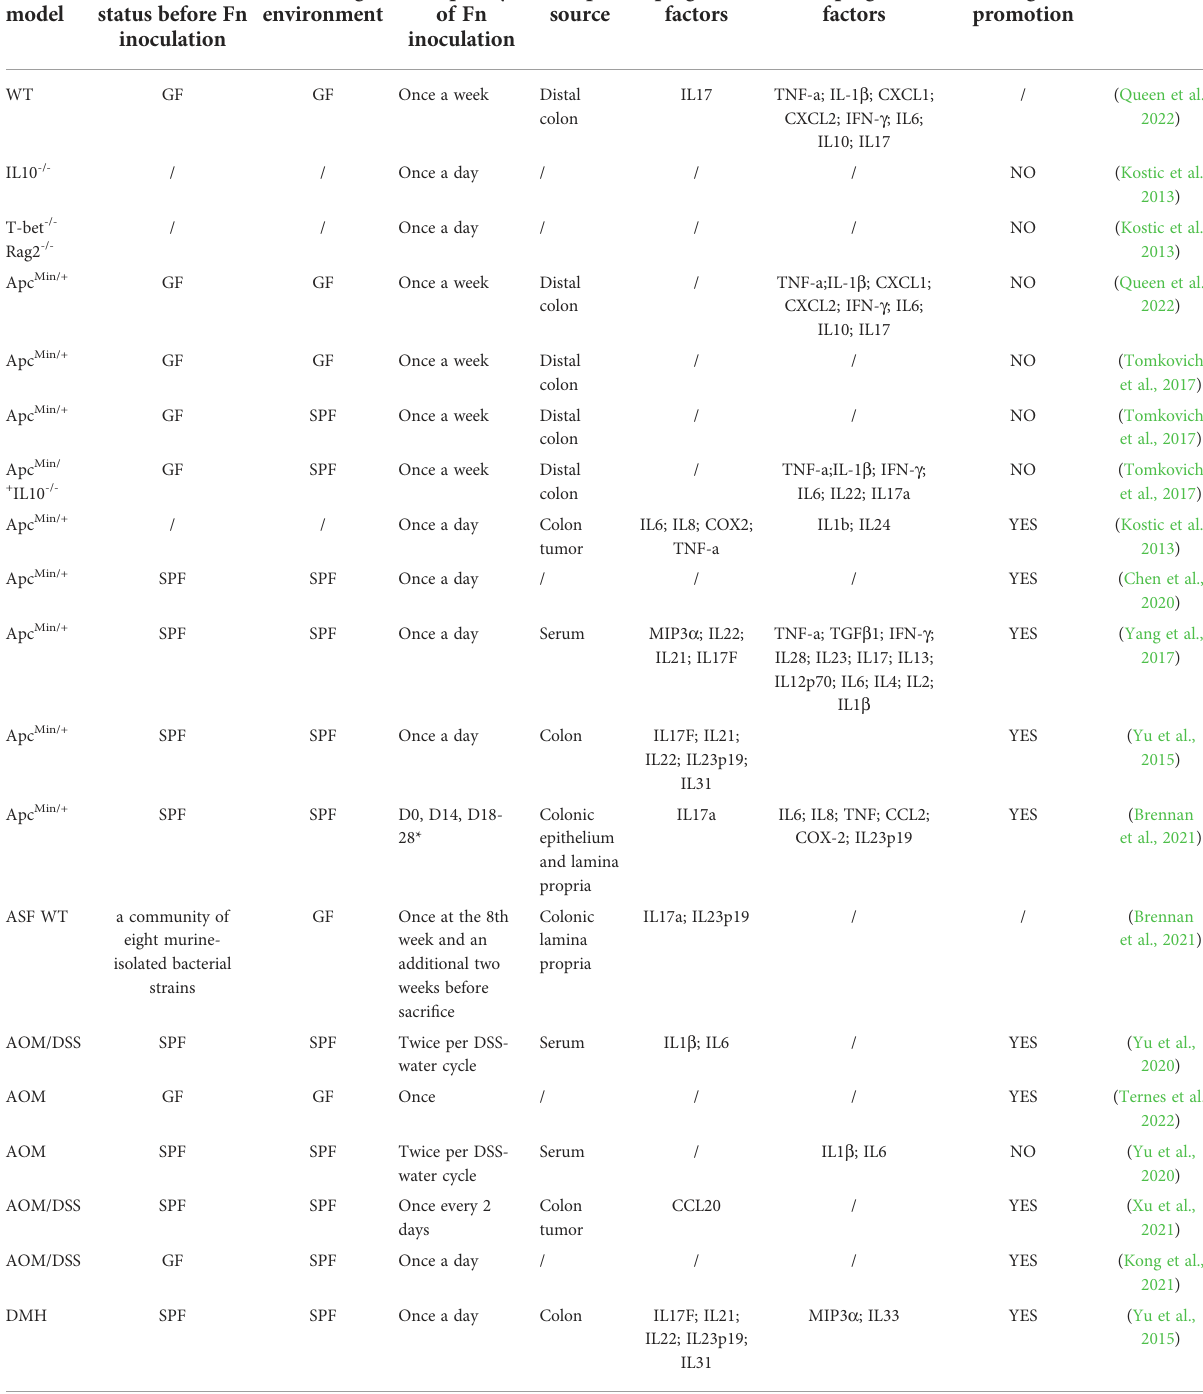
TABLE 2 Effects of Fn gavage on in fl ammatory factor and tumorigenesis of colon in various mouse models. Murine